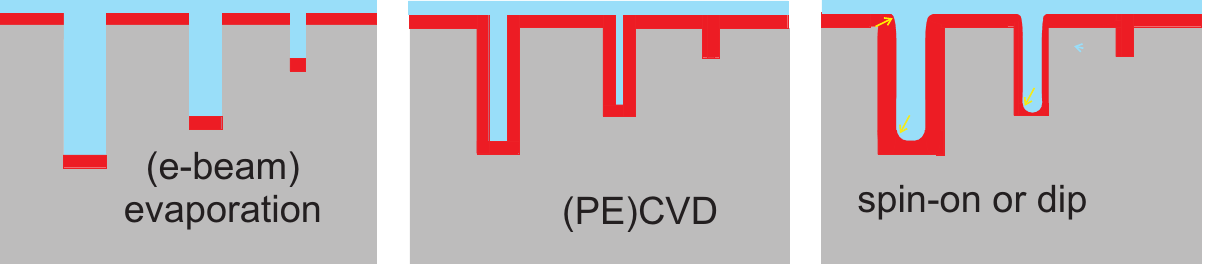
Figure 1. The perfect conformal coating even of very rugged surfaces is second to none for (PE)CVD (middle). Due to the very low pressure which prevents scattering, thereby causing a a very directed beam from source to target, techniques as e-beam evaporation or epitaxy cannot coat surfaces which are orientated parallel to the beam (LHS). Dipping or spin-on techniques suffer from the high viscosity and surface tension of the solvent which causes protruding noses and rounded corners (RHS, gray: substrate, red: deposited film, blue: